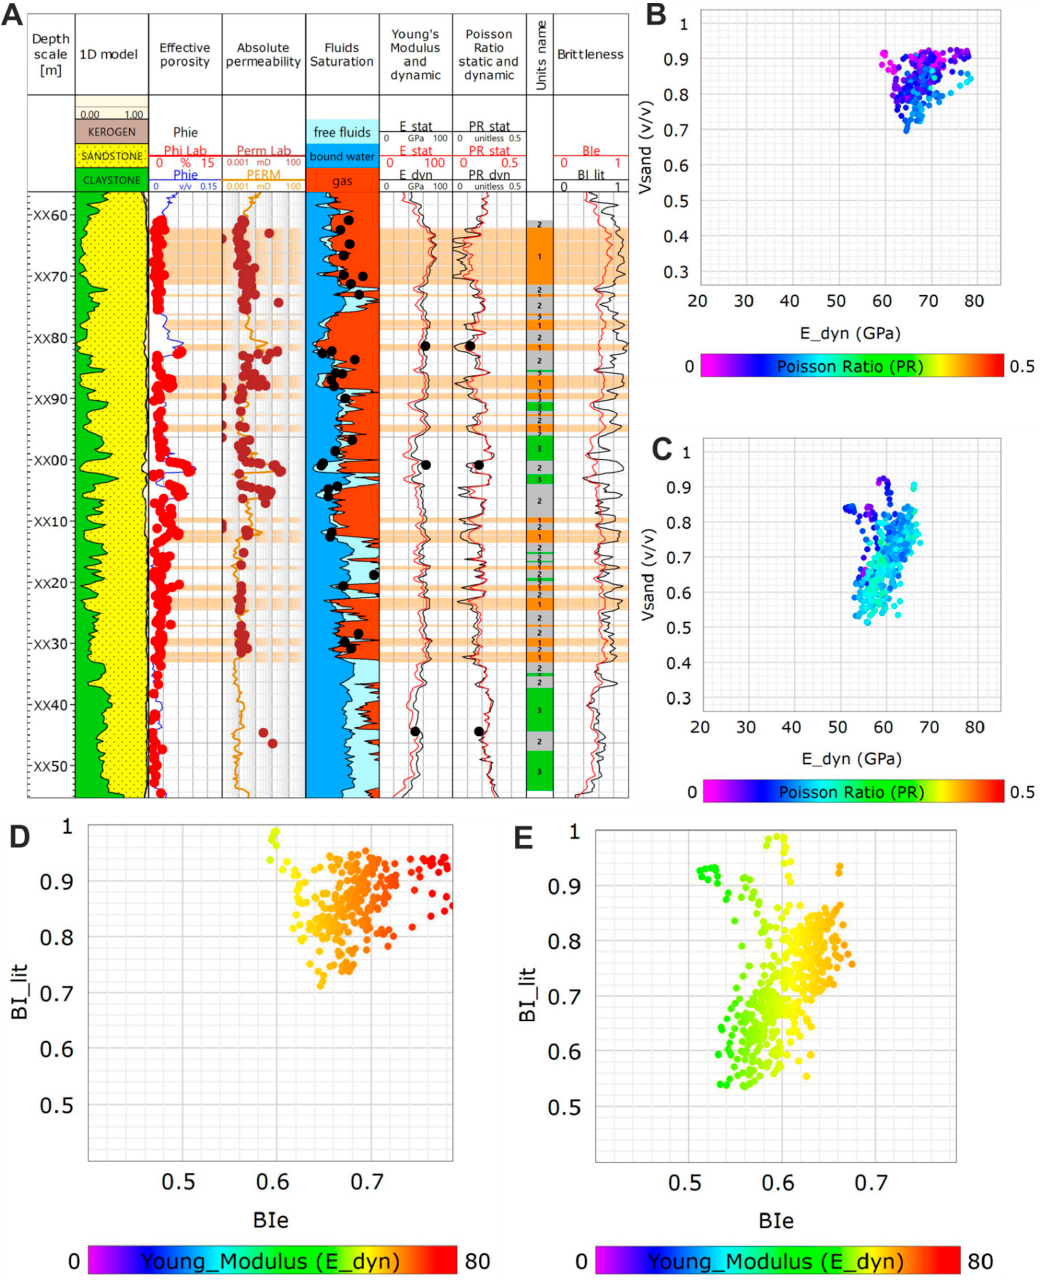
Figure 6. Geomechanical and petrophysical characterization in borehole W ‐ 3: petrophysical and geomechanical interpretation of Middle Cambrian sandstone reservoir in well W ‐ 3 ( A ), cross ‐ plot between the volume of quartz (Vsand) and dynamic Young’s modulus (E_dyn) for unit one (tight sandstone) ( B ), cross ‐ plot between the volume of quartz (Vsand) and dynamic Young’s modulus (E_dyn) for unit two (sandstone of higher porosity) ( C ), cross ‐ plot between brittleness BI_lit and BIe for unit 1, color scale refers to Young’s Modulus values ( D ) cross ‐ plot between brittleness BI_lit and BIe for unit 2, color scale refers to Young’s modulus values ( E ).